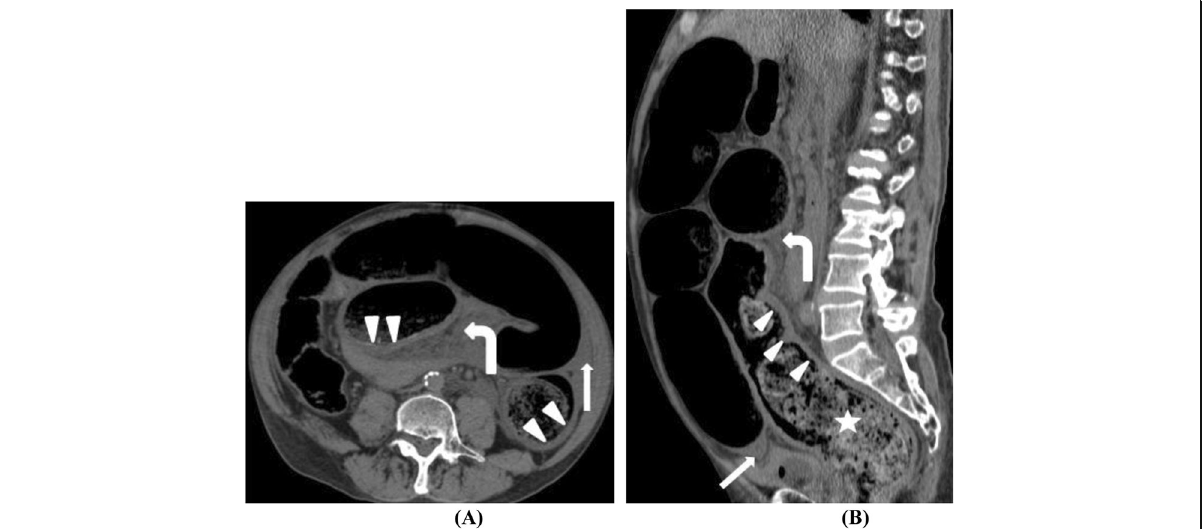
Fig. 11 Fecal impaction and sterocoral colitis in a 65-year-old man presented with constipation and acute abdominal pain. CT abdomen and pelvis non-contrast phase ( a ) axial image and ( b ) sagittal image, showing a large volume of fecal matter distending the rectum, sigmoid colon, and transverse colon (star), colon wall thickening with sub mucosal edema (white arrowheads), extensive pericolonic fat stranding (curved arrow) and free fluid collection